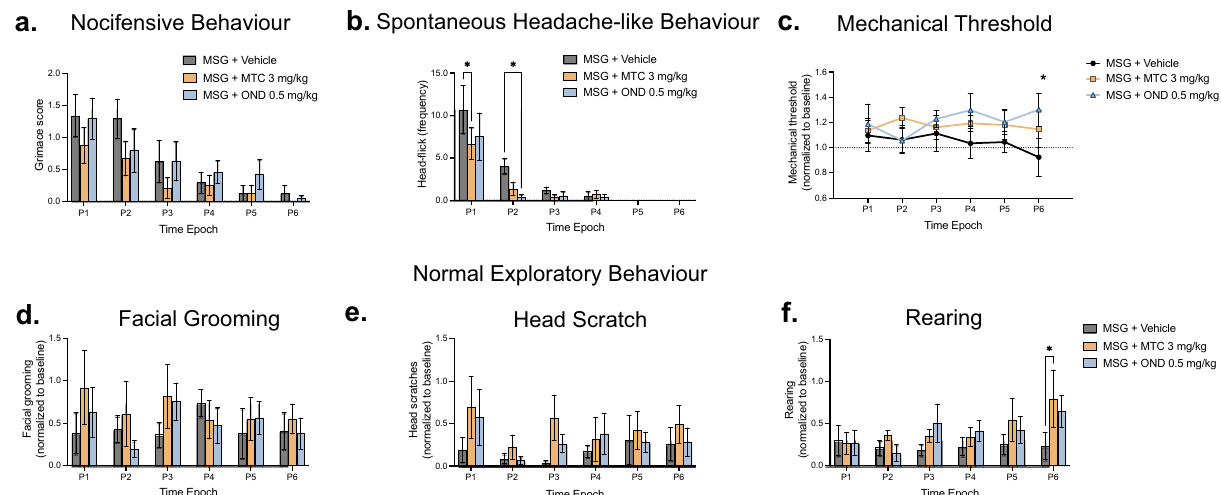
Figure 6. OND and MTC ameliorated MSG induced headache-like behaviours but not nocifensive or exploratory behaviours. The effects of MTC (3 mg/kg; i.p.), OND (0.5 mg/kg; i.p.) and vehicle in combination with MSG (1000 mg/kg; i.p.) on ( a ) Grimace scores ( b ) Head-flick frequency ( c ) Mechanical withdrawal threshold (OND vs Vehicle *P < 0.05) ( d ) Facial grooming ( e ) Head scratches and ( f ) Rearing in 6 male rats. Both MTC and OND reduced head flick frequency. MTC also had a late effect on MSG-induced suppression of rearing behaviour. However, neither MTC nor OND had a significant effect on nocifensive or grooming behaviours. Data are mean ± SEM (n = 6). *P < 0.05. Time Epoch = P1 (0–10 min), P2 (10–20 min), P3 (20– 30 min), P4 (30–40 min), P5 (40–50 min) and P6 (50–60 min) post